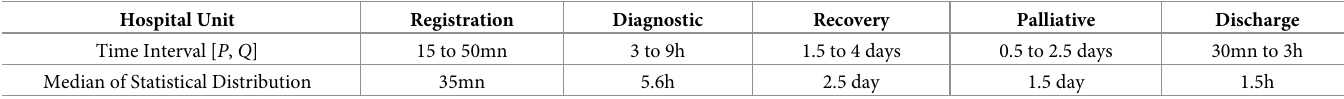
Table 3. Time window for the patient stay at each stage in reference to the workflow of Fig